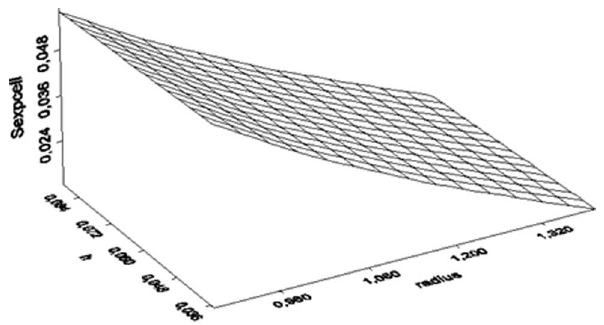
Figure 3. Three dimensional illustration of the Sexp for 900 MHz vs h and radius.